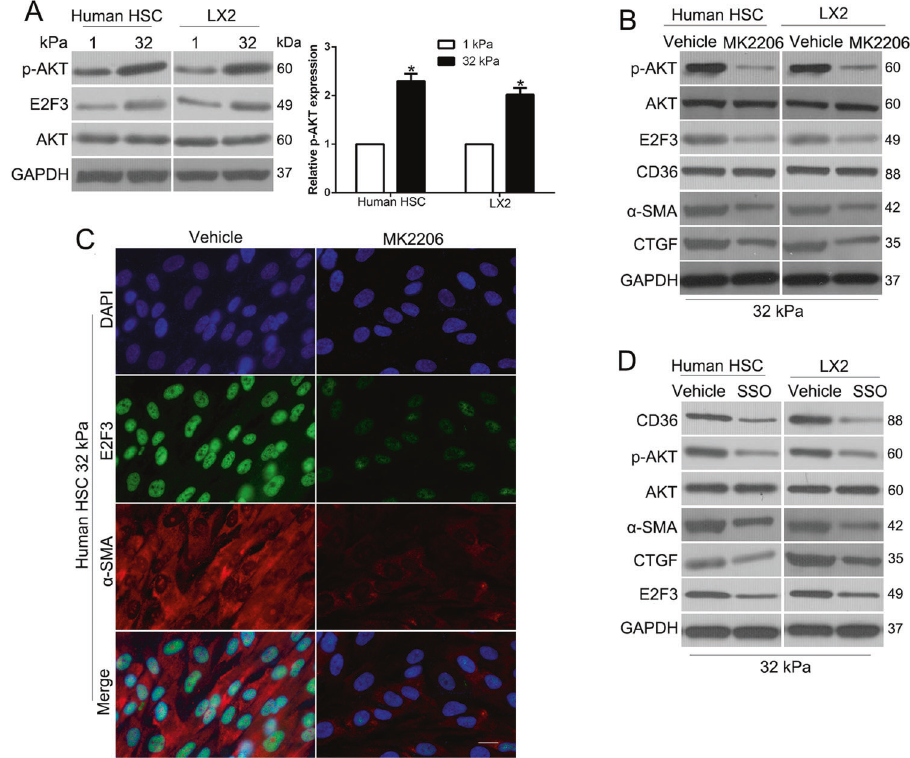
Fig. 4 Stiffness promoted E2F3 expression by activating a CD36-AKT pathway. A WB revealed that stiffness-induced AKT phosphorylation at S473. B AKT inhibitor MK2206 reduced p-AKT(S473), total E2F3, and HSC activation markers, α -SMA, CTGF level of HSCs. Data represent multiple repeats with similar results. C IF showed that MK2206 suppressed stiffness-mediated E2F3 overexpression and activation of HSCs. D CD36 inhibitor SSO reduced p-AKT, and E2F3 levels of